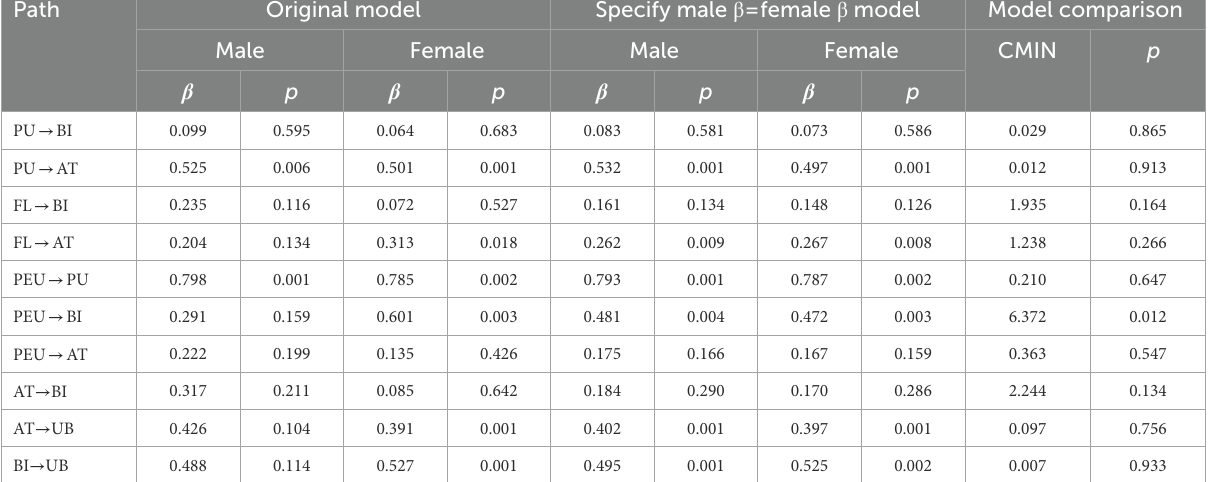
TABLE 13 Gender moderating effect